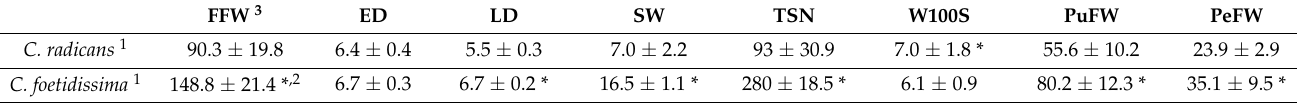
Table 1. Morphological characteristics of Cucurbita foetidissima and C. radicans fruits. Morphological variables were measured in fruits of C. foetidissima and C. radicans plants collected in the wild from sites localized in the state of Jalisco, Mexico.